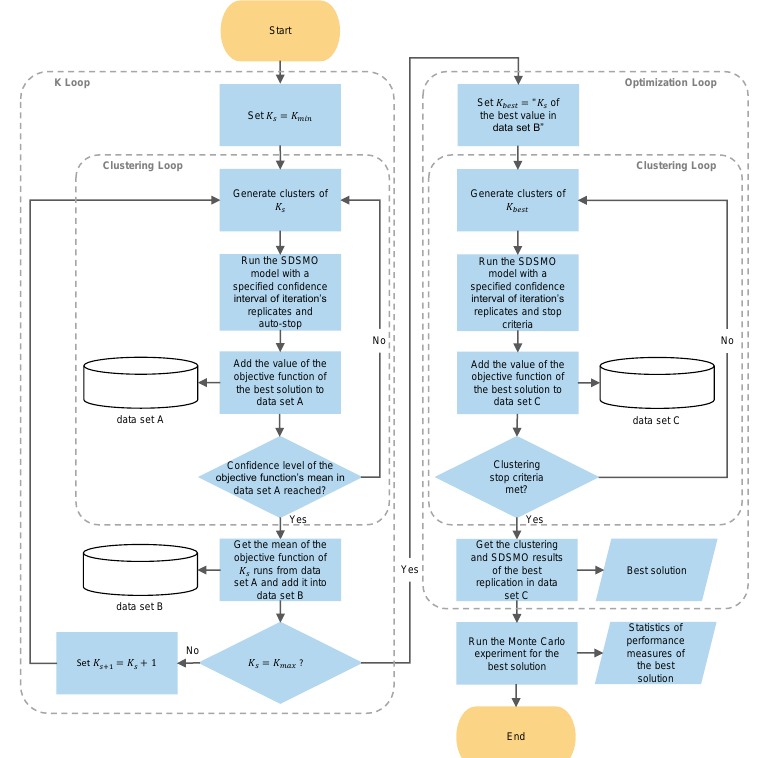
Figure 6. The proposed iterative sequential approach to link clustering to stochastic